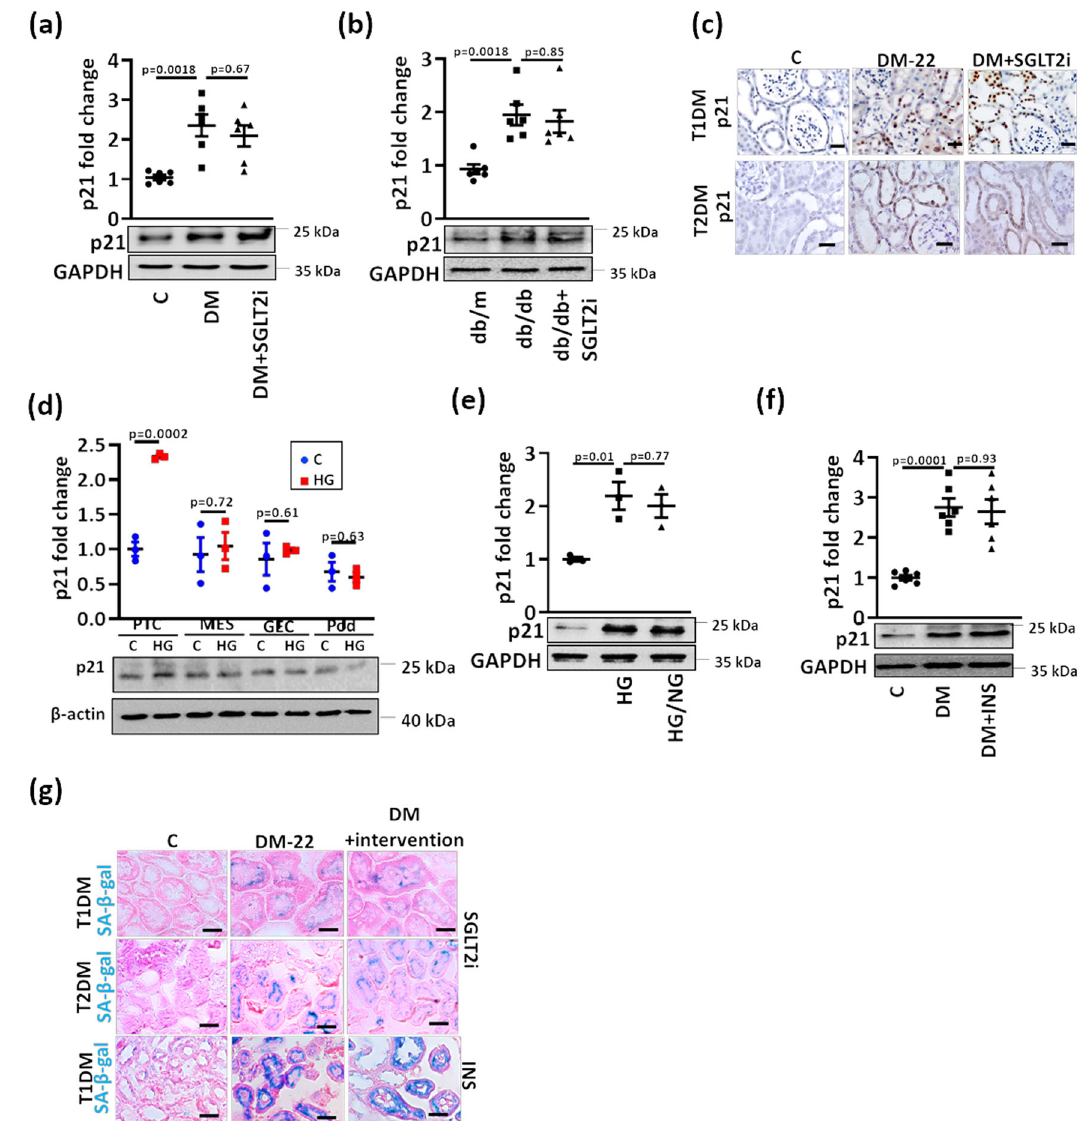
glucose (5mM, C), high glucose (48h of 25mM, HG), or high glucose followed by normal glucose (25 and 5mM, each for 24h, HG/NG). Exemplary immunoblots (bottom, GAPDH: loading control) and dot plots summarizing results (top). f Sustained p21 expression in vivo (STZ-model) despite reducing glucose levels using insulin (DM+INS) as compared to mice with persistently elevated glucose levels(DM-22)and normoglycemiccontrols(C).Exemplaryimmunoblots(bottom, GAPDH: loading control) and dot plots summarizing results (top). g Exemplary histological images of SA- β -gal stain (senescence associated β -galactosidase, blue; eosin counterstain) in T1DM (STZ-model, top and bottom) and T2DM (db/db model, middle) despite reducing glucose levels (DM+intervention; SGLT2i, top andmiddleorinsulin,INS,bottom)ascomparedtomicewithpersistentlyelevated glucose levels(DM-22)ornormoglycemiccontrols(C). Scalebarsrepresent20 µ m. Dotplotsre fl ectingmean±SEMof6micepergroupor3independentexperiments; one-wayANOVA withSidak ’ s multiple comparisontest (a,b,e,f);t-test comparing C versus HG for each cell line (d) Gels/blots were processed in parallel; source data are provided as a Source Data fi